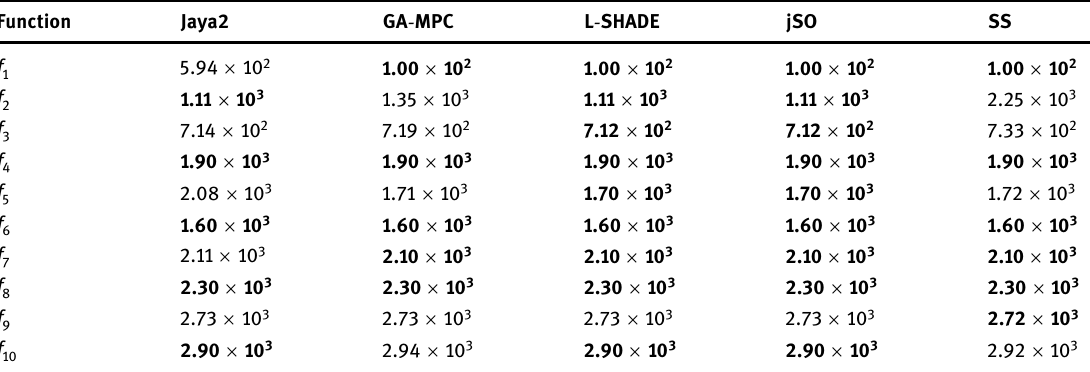
Table 14: The CEC 2020 ( = D 10 ) median function values achieved by Jaya2, GA - MPC, L - SHADE, jSO, and SS over 30 runs and 100,000 function evaluations Function